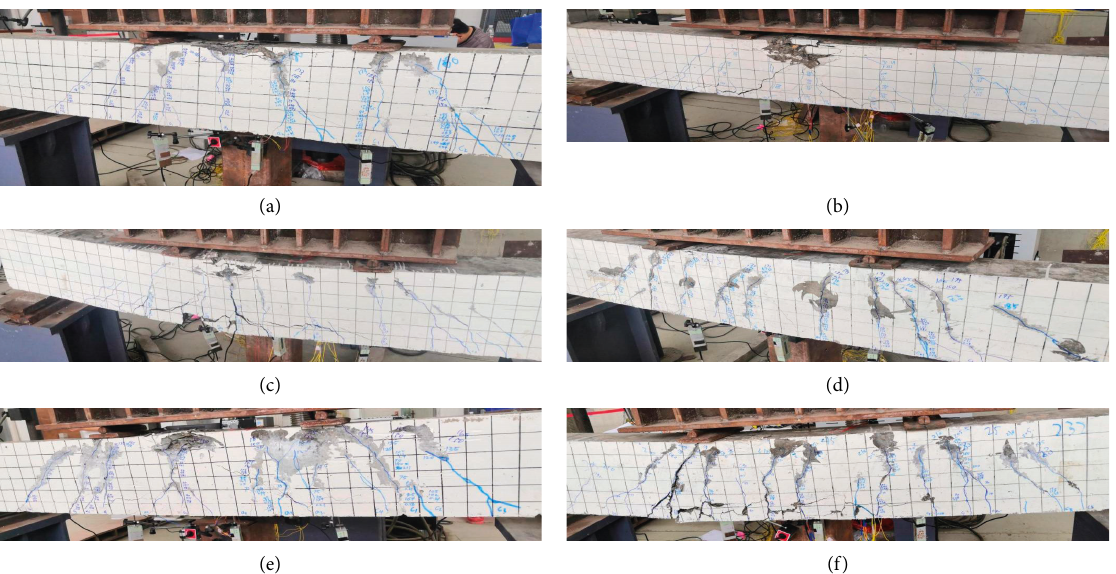
Figure 4: The distribution of cracks in the actual failure of the test beam. (a) BFRC1. (b) BFRC2. (c) BFRC3. (d) BFRC4. (e) BFRC5. (f) BFRC6.